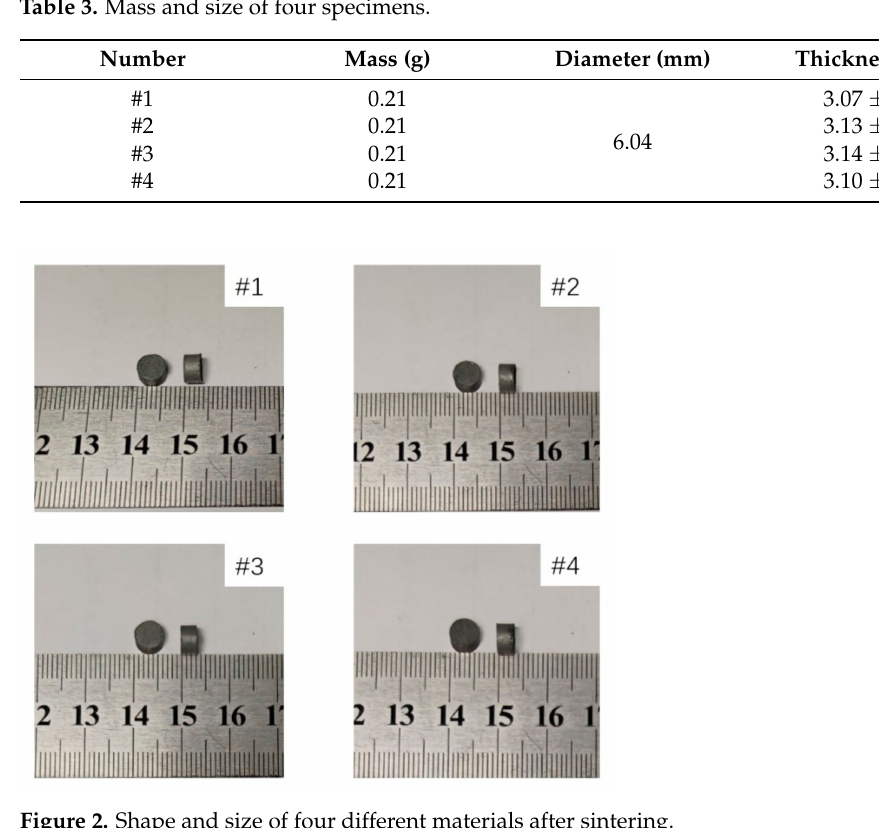
Figure 2. Shape and size of four different materials after sintering.